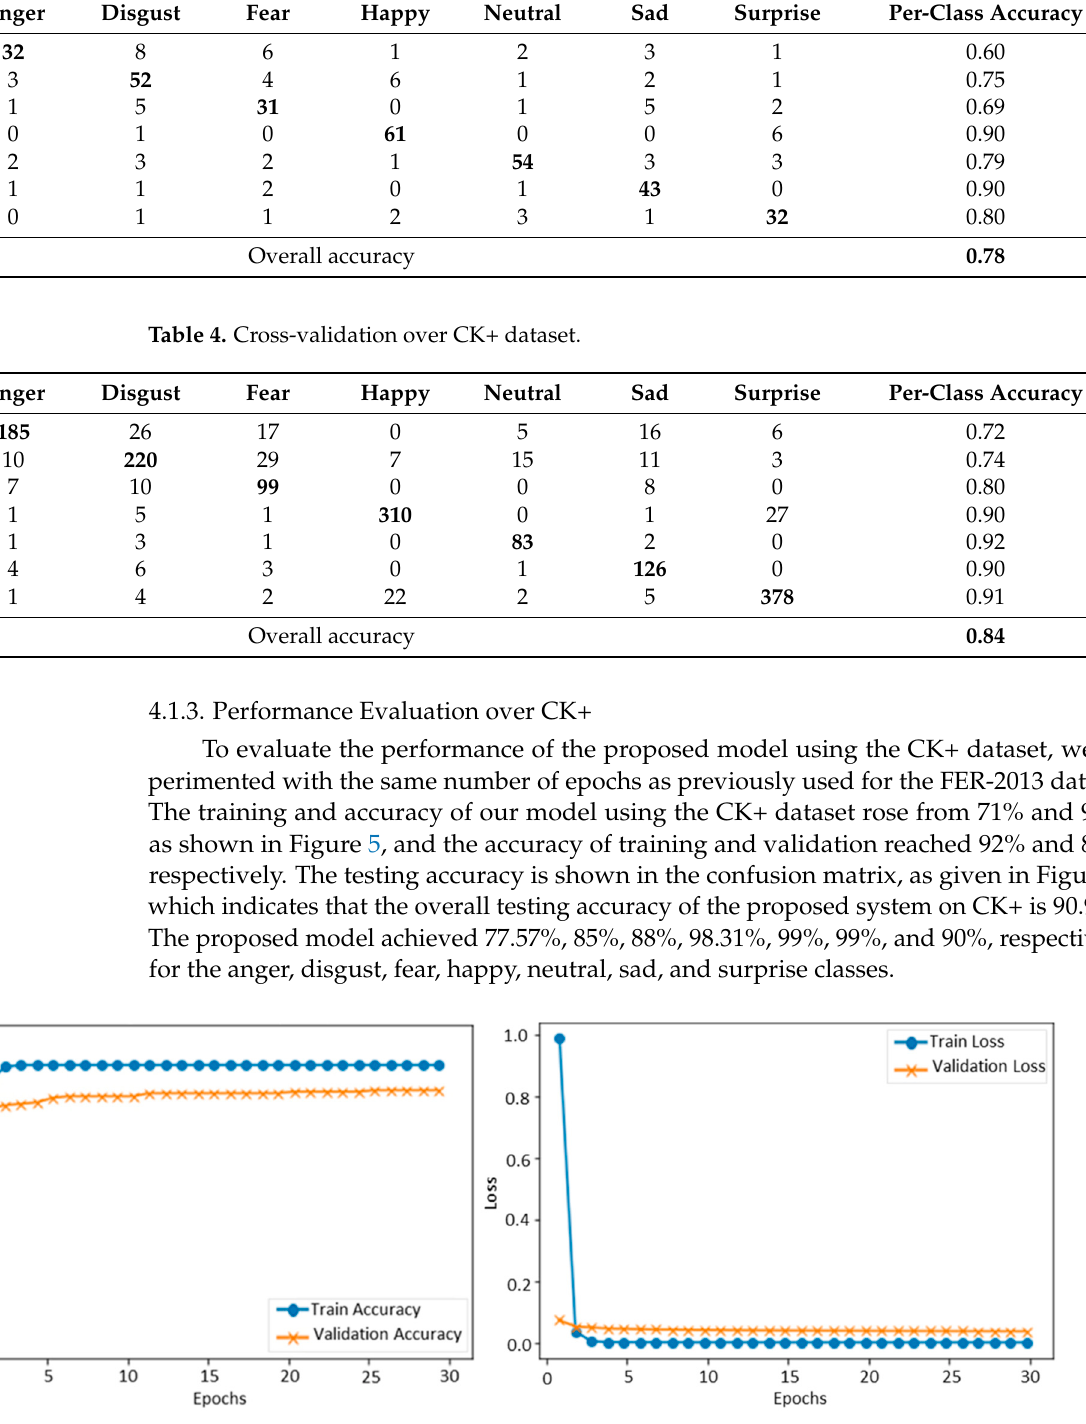
Figure 6. Confusion matrix of the proposed model over the CK+ dataset. 4.1.4. Cross-Validation of CK+ Trained Model over FER-2013 and KDFE Dataset The performance of the CK+ dataset-trained model was cross-validated on FER-2013 and CK+ datasets. We selected test samples from each class of the mentioned datasets and performed a cross-validation to verify the robustness of the model. Tables 5 and 6 present the results.